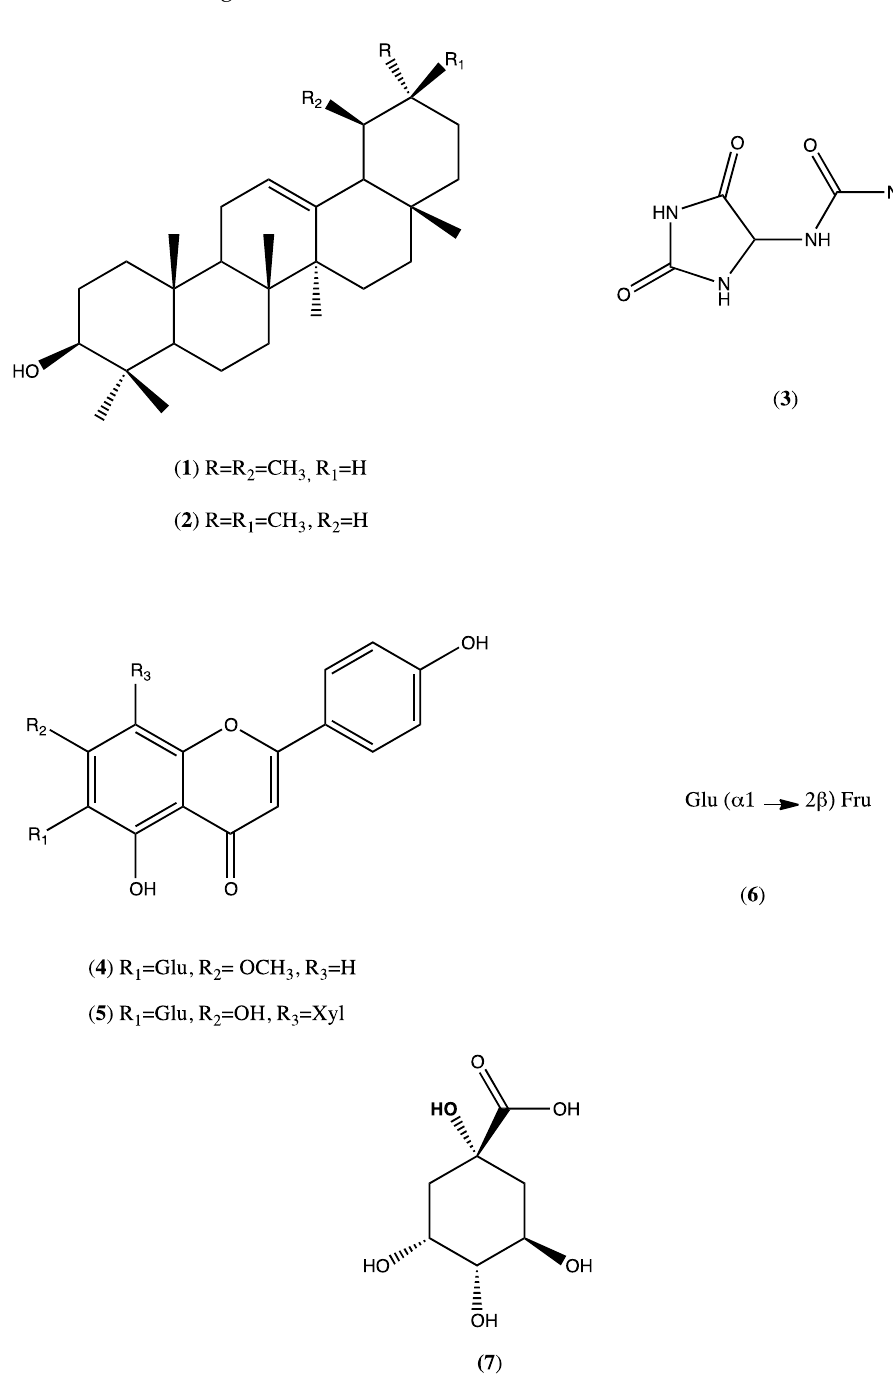
Figure 2. Compounds isolated and identified from Machaerium hirtum .